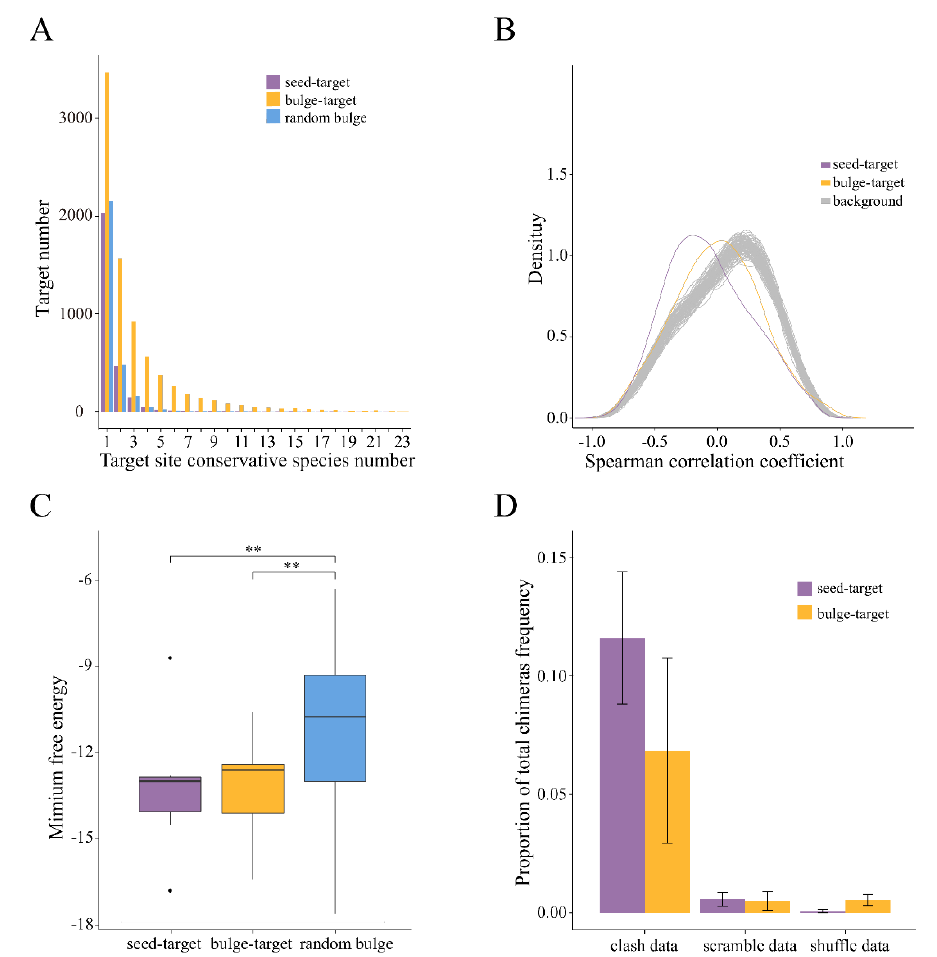
Figure 2. The CG dimer miRNAs and bulge-targets’ interactome. ( A ) Targets with bulge between CG dimer have higher conservative rate. The seed-targets and bulge-targets between CG dimer were compared to the random bulge control using conservation rates in 23 vertebrate species. The x axis is the conservation rates. The y axis is the number of targets for each conservation rates. ( B ) The CG dimer miRNA suppression of the bulge-targets expression. Cumulative distribution of correlation coefficient between CG dimer miRNAs and their targets expression level. ( C ) Minimum free energy between CG dimer miRNAs and seed-targets, bulge-targets, and random bulge targets. A boxplot was used to indicate the distribution of the minimum free energy for each interaction type. ** p < 0.001, compared with random bulge. ( D ) CLASH data validation of CG dimer miRNAs and bulge-targets interaction. The proportion of canonical seed interaction and non-canonical bulge interaction among real CLASH chimeras scramble and shuffle data.